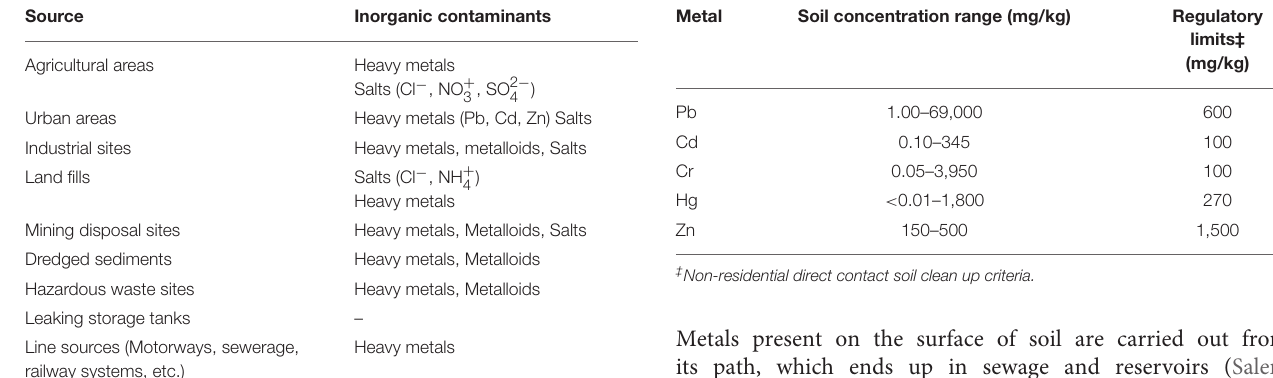
TABLE 4 | Typical sources of inorganic substances contributing for ground water contamination (Source: Spiegel and Maystre, 1998).